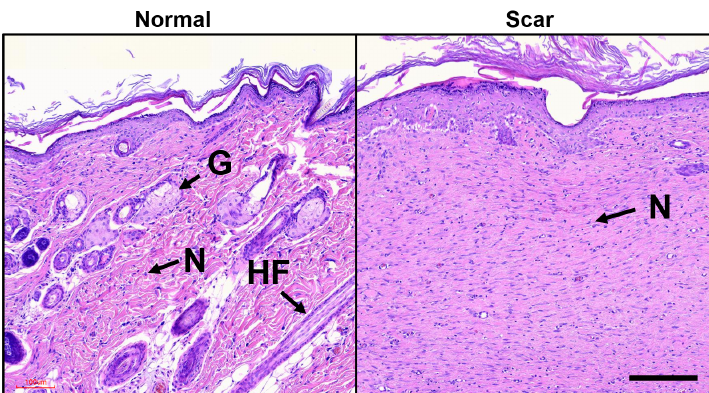
Figure 2. Morphology of skin tissue stained with hematoxylin and eosin (HE): normal tissue ( left ) shows hair follicles (HFs), gland (Gs), and nuclei (N) whereas scar tissue ( right ) yields the absence of both HFs and Gs (scale bar = 100 µm; 10 × ).